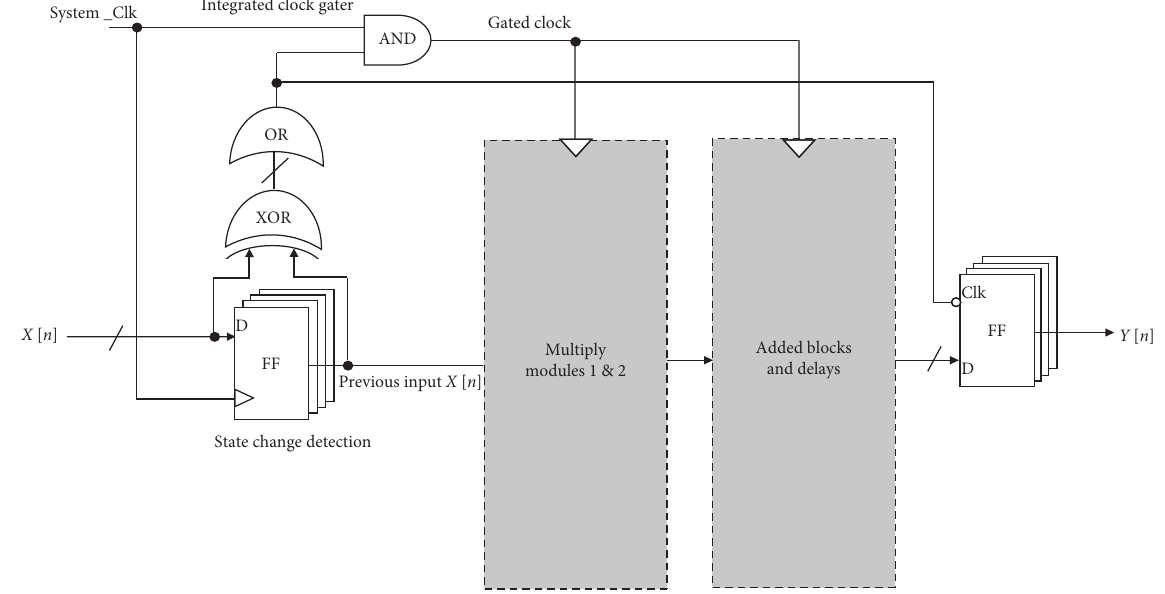
Figure 7: Filter architecture with a DDCG integrated into a k